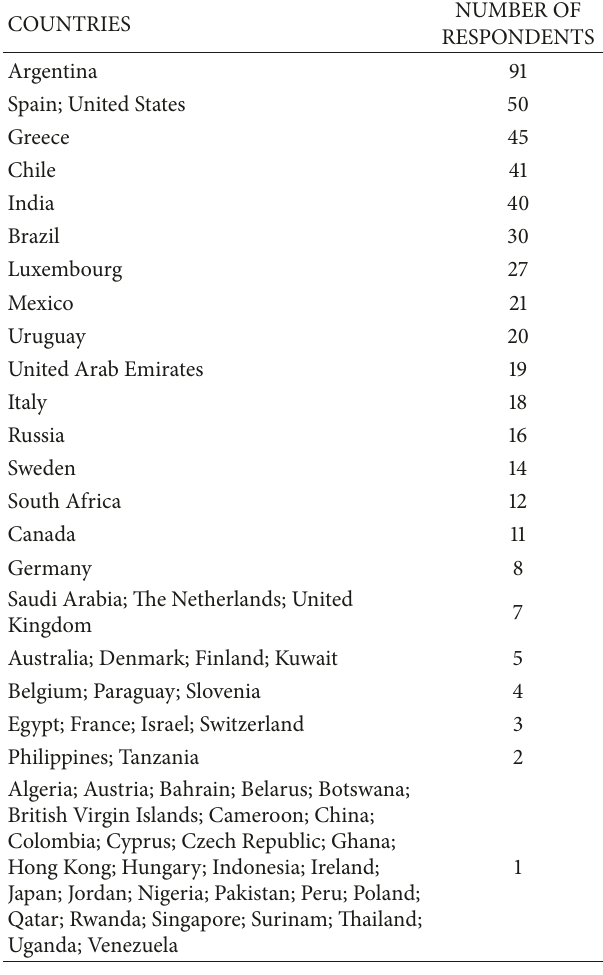
Table 3: Countries and number of responses (ordered by number of responses). When several countries are indicated in the same row, the number of respondents stands for the number of answers received from each country (i.e., 50 answers from Spain and 50 answers from the United